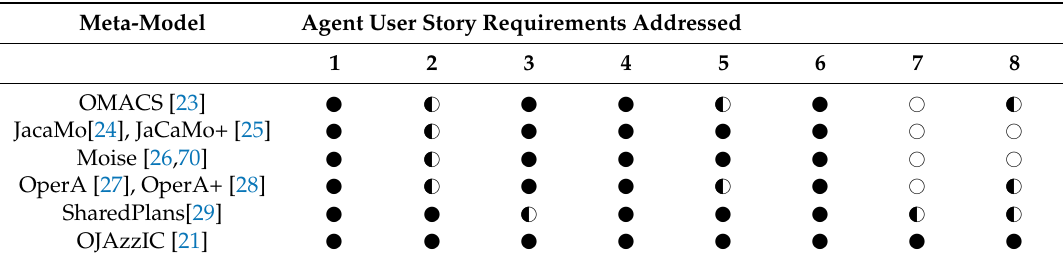
Table 3. Agent user story requirements addressed by each approach.